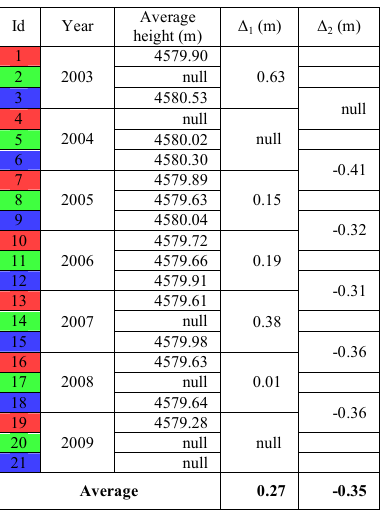
Table 2. The seasonal elevation array and water level differences between defined seasons of the Palku Tso lake An average water level difference between the defined seasons is also obtained, by taking the average of all available differences. The